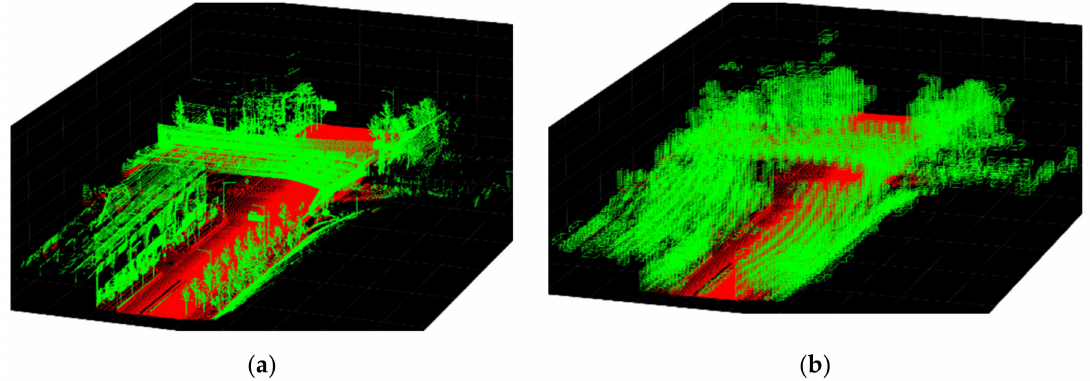
Figure 5. Visualization of voxelization using sample point cloud data. ( a ) Example analysis area required for each observer pose; ( b ) voxelization of point cloud data.